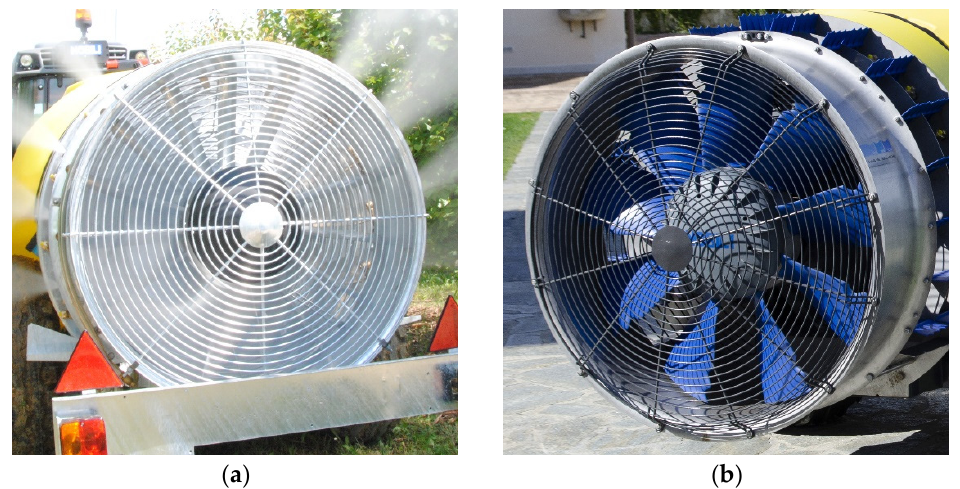
Figure 4. Nobili 90 Super installed on the mSprayer ( a ) and Nobili HF95 installed on the eSprayer ( b ).